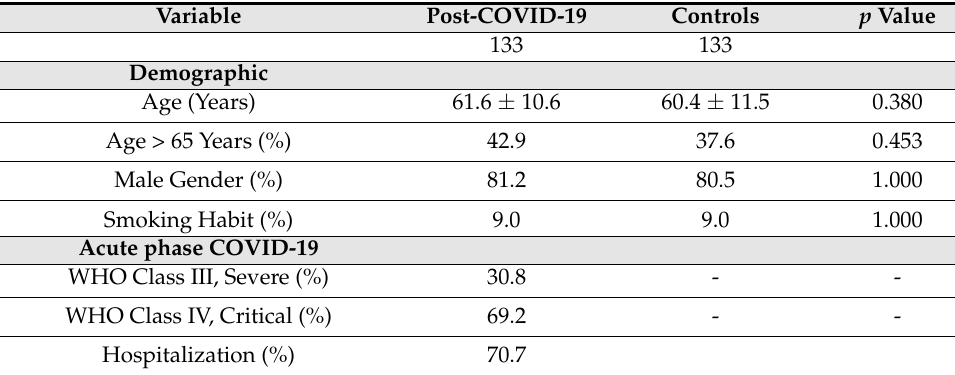
Table 1. Demographic and clinical characteristics of convalescent coronavirus disease 2019 (COVID-19) patients and